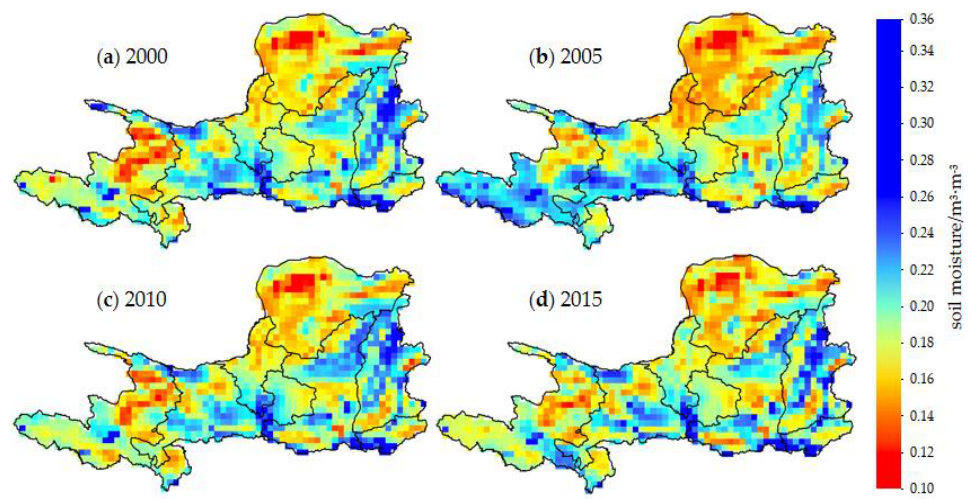
Figure 3. Spatial distribution of annual SM in the YRB at four specific times: ( a ) 2000, ( b ) 2005, ( c ) 2010, and ( d ) 2015.